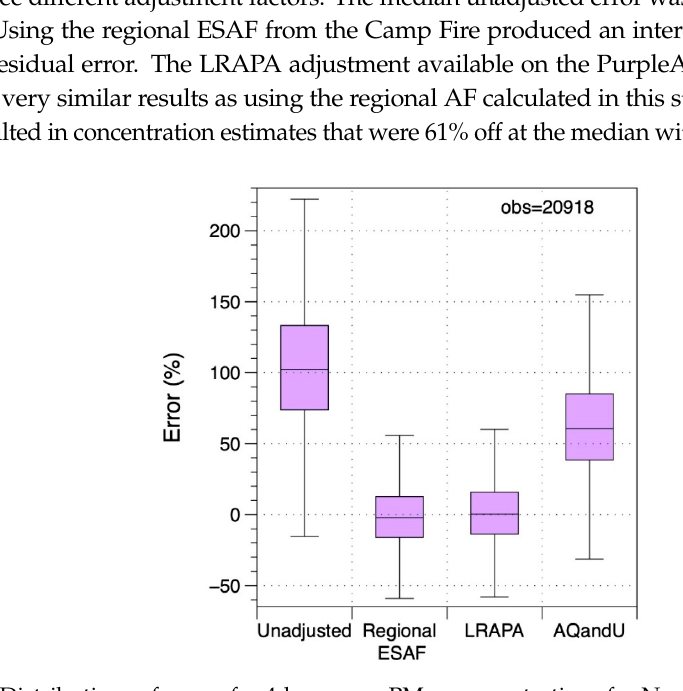
Figure 7. Distributions of errors for 4-h average PM 2.5 concentrations for Northern California PA-II monitors compared to regulatory monitors for the Camp Fire using different adjustment factors.